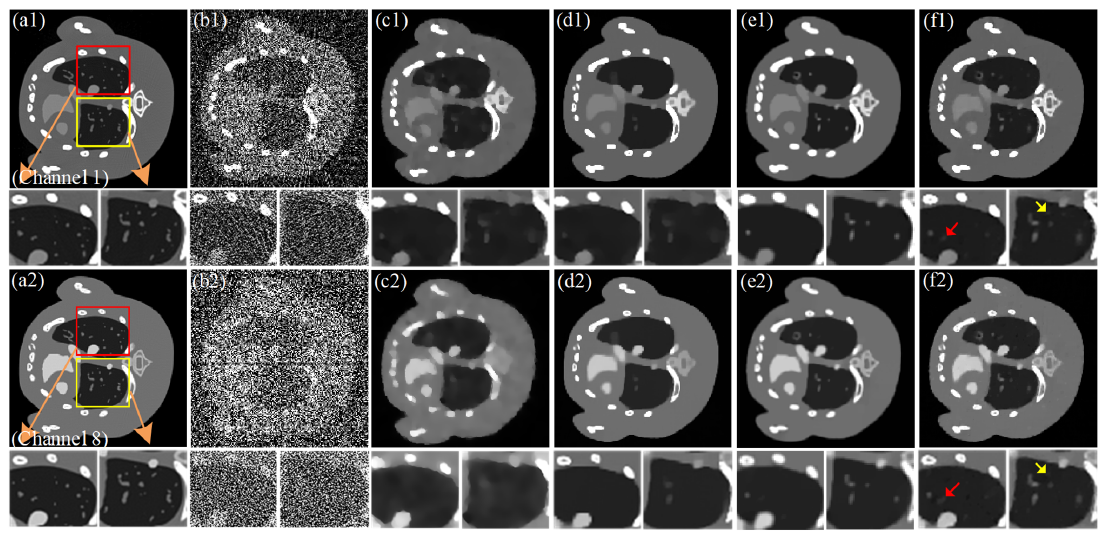
Figure 3. Reconstructed images from 80 projections using different methods. The first two rows are the first channel and ROIs, the last two rows are the eighth channel and ROIs. From left to right, the columns are Ground Truth ( a ), FBP ( b ), TV ( c ), TVLR ( d ), TDL ( e ), and our algorithm ( f ). The display windows are [0, 0.25] cm − 1 and [0, 0.06] cm − 1 , respectively.